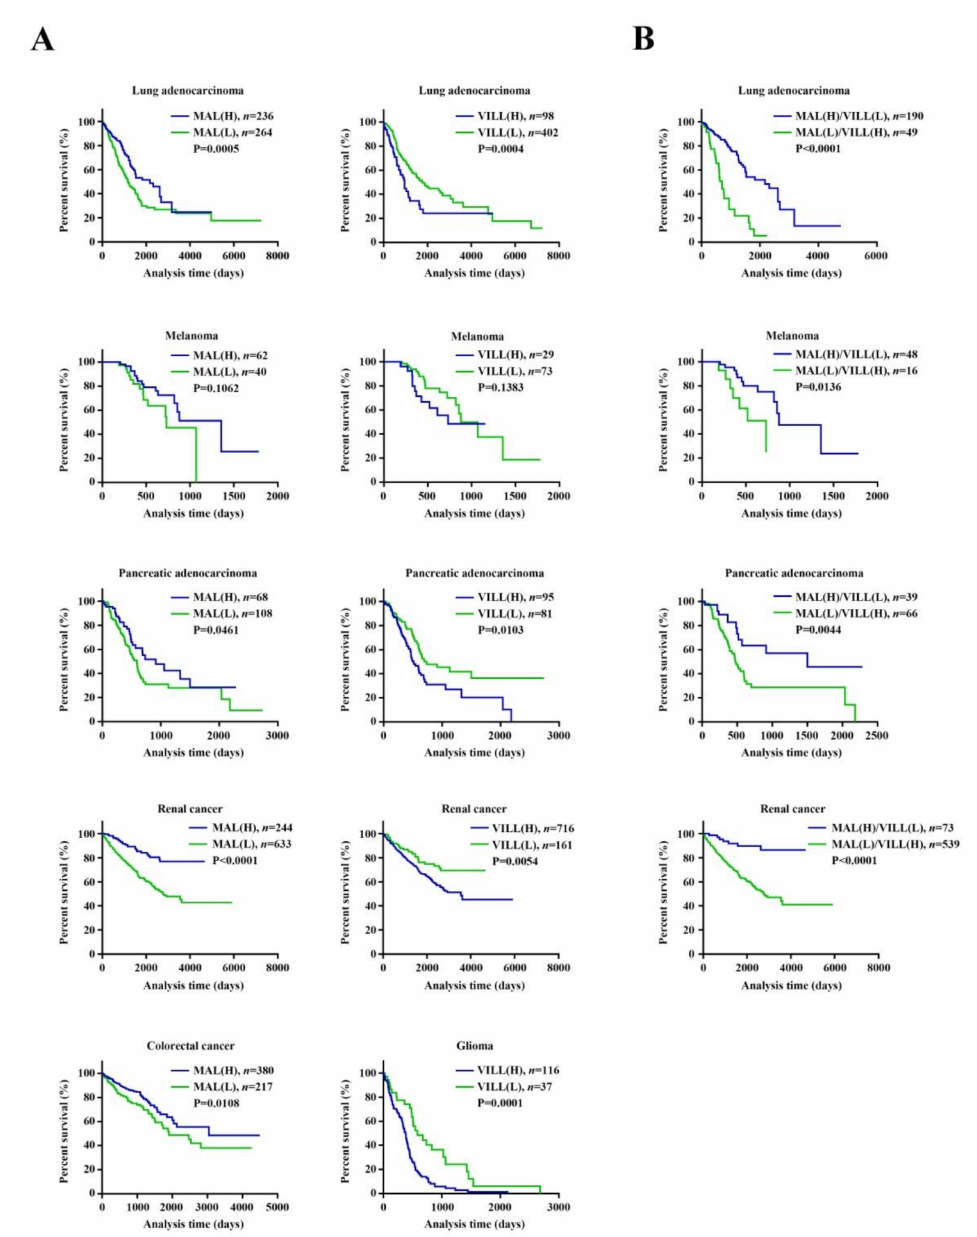
Figure 3. The gene expression of myelin and lymphocyte protein ( MAL ) and/or vilin-like ( VILL ) had prognostic value for various cancers. ( A ) Kaplan–Meier survival analysis implicated MAL or VILL in various cancers. ( B ) Kaplan–Meier survival analysis implicated both MAL and VILL in various cancers. The information about cancer type, patient number, and p -value is inscribed at each panel. The gene level was defined as fragments per kilobase of exon per million reads (FPKM). The median cutoff was used to group patients into low (L) and high (H) expression of MAL and/or VILL . The p -values are generated by the log-rank